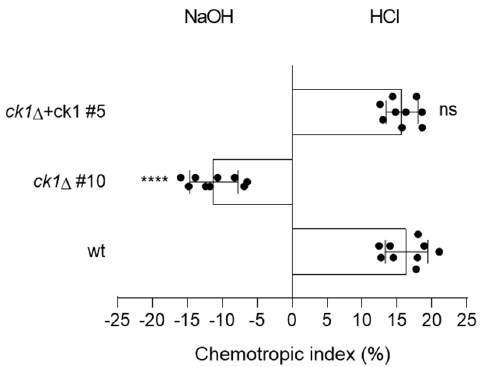
Figure 6. C k1 is required for the chemotropic response to an acid pH gradient. The directed growth of germ tubes of the indicated F. oxysporum strains was determined after 8 h exposure to opposing gradients of 25 mM HCl and NaOH. p < 0.0001 (****), ns, not significant versus wt according to Welch’s t ‐ test. Data show the mean and standard deviation from three independent experiments with three replicates (n = 500 germ tubes per experiment).